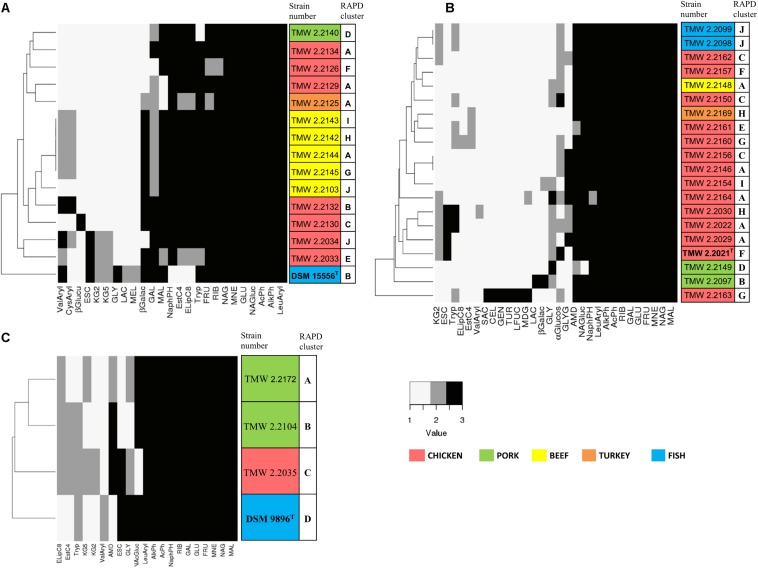
Clustering of selected strains by metabolic properties based on API 50CH and API ZYM. The reactions prove acid production from single carbohydrates (API 50CH) and presence of selected enzymes (API ZYM). Each clustering shows only reactions that were positive at least in one isolate. Reactions were scored as 1 (negative reaction), 2 (weak positive reaction), and 3 (strong positive reaction). The different isolation sources are displayed in colors and type strains are marked with bolt letters. (A)
P. phosphoreum, type strain DSM 15556T, (B)
P. carnosum, type strain TMW2.2021T, (C)
P. iliopiscarium, type strain DSM 9896T. API50ch: GLY, glycerol; RIB, D-ribose; GAL, D-galactose; GLU, D-glucose; FRU, D-fructose; MNE, D-mannose; MDG, methyl-αD-glucopyranoside; NAG, N-acetylglucosamine; ESC, esculin; CEL, D-cellobiose; MAL, D-maltose; LAC, D-lactose; MEL, D-melibiose; SAC, D-saccharose; AMD, starch; GLYG, glycogen; GEN, gentiobiose; TUR, D-turanose; LFUC, L-fucose; KG2, potassium 2-ketogluconate; KG5, potassium 5-ketogluconate. APIzym: AlkPh, alkaline phosphatase; EstC4, esterase (C4); ELipC8, esterase lipase (C8); LeuAryl, leucine arylamidase; ValAryl, valine arylamidase; CysAryl, cystine arylamidase; Tryp, trypsin; AcPh, acid phosphatase; NaphPH, naphthol-AS-BI-phosphohydrolase; βGalac, β-galactosidase; βGlucu, β-glucuronidase; αGlucos, α-glucosidase; NAG, N-acetyl-β-glucosaminidase.